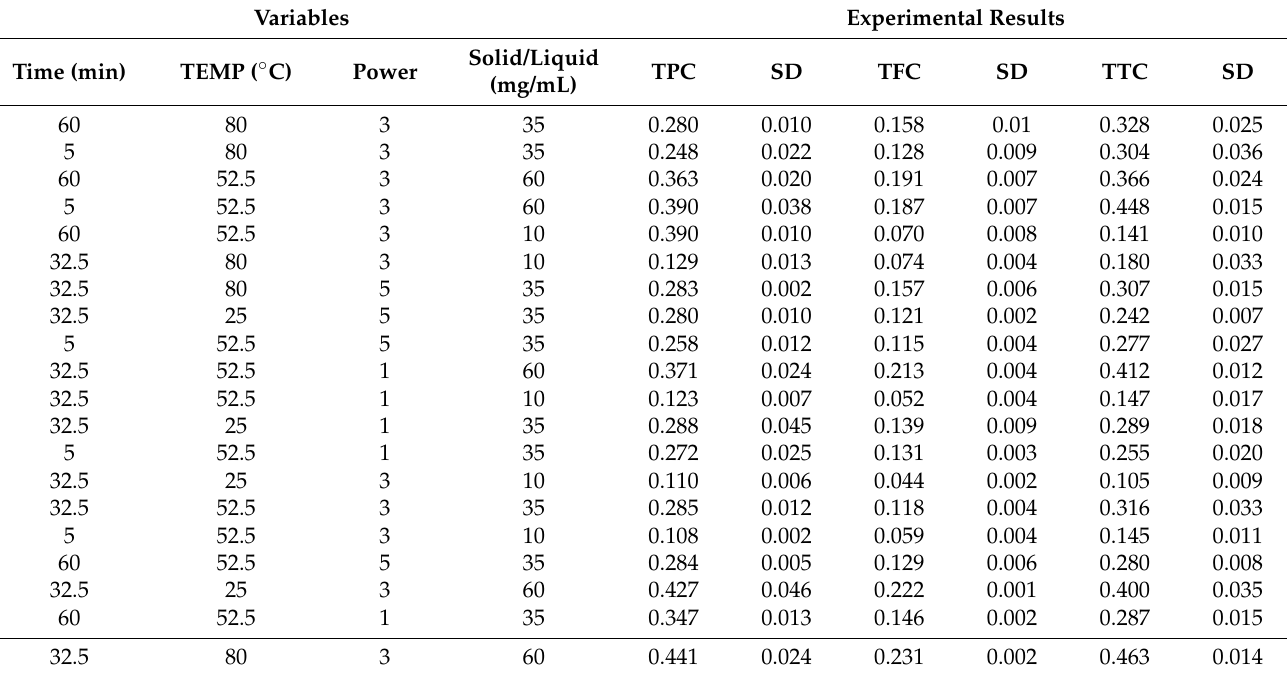
Table 2. Experimental design matrix with coded variables and experimental data for total polyphenols, total flavonoids and total